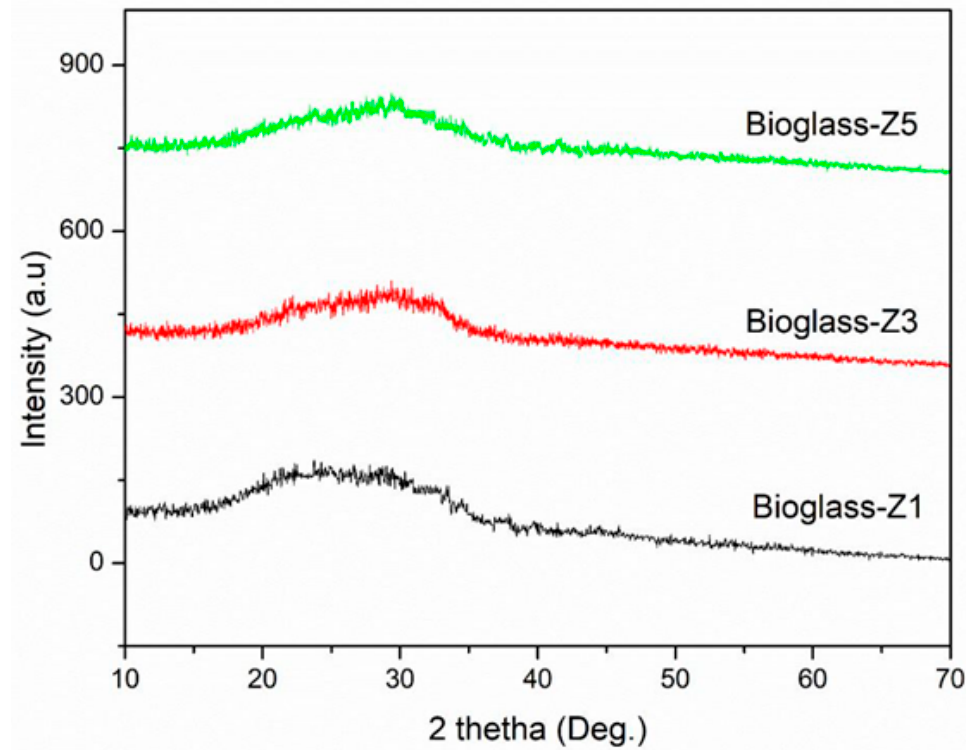
Figure 2. XRD patterns of bioactive glasses 70SiO 2 –(30-x)CaO–xZnO (mol.%, x = 1, 3, 5).